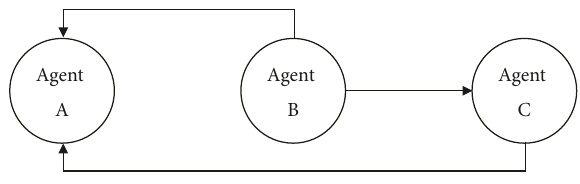
Figure 1: Stylized directed investor